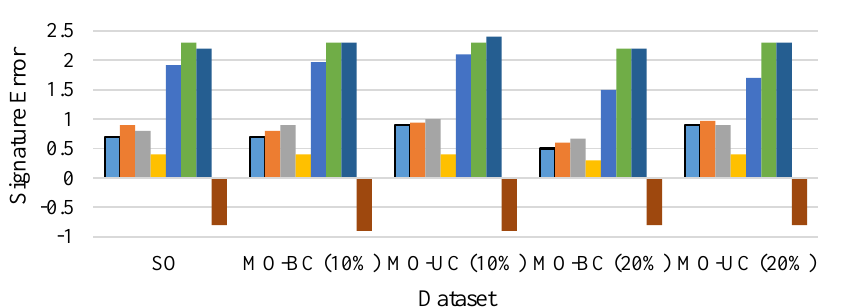
Figure 22. Discharge variance errors based on observations and simulations of five datasets using two main calibration approaches (SO & 4 algorithms parameterization of MO-SB).